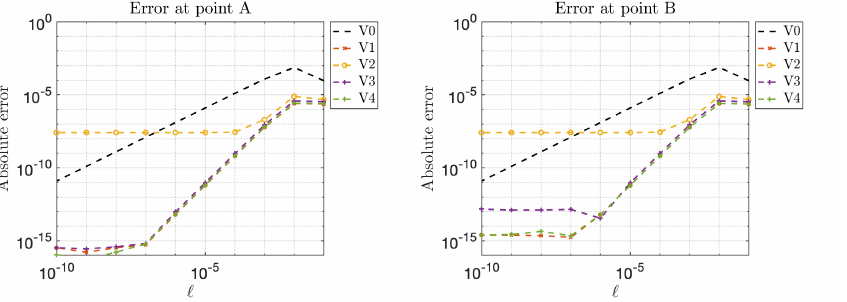
· ( x ∗ − x 0 ) with x 0 = ( 0,0,0 ) , outside | x ∗ − x 0 | 3